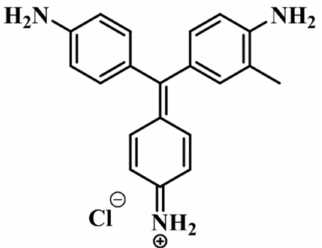
Figure 1. Chemical structure of basic fuchsine